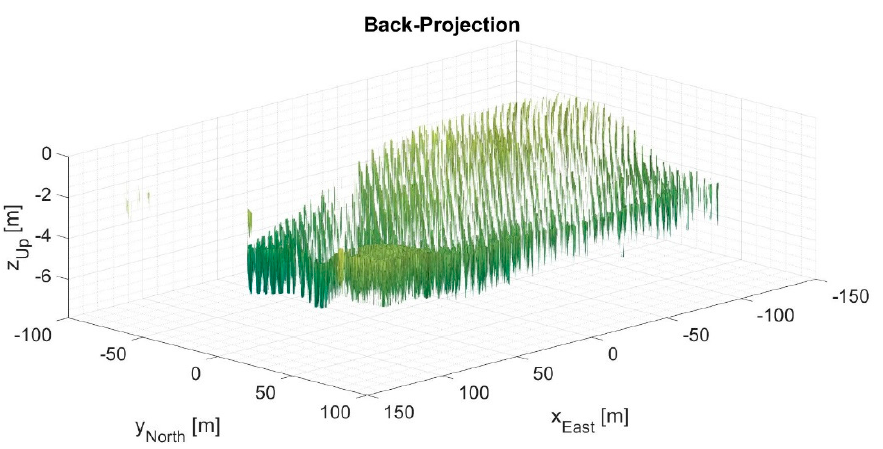
Figure 9. 3D output image processed by the back ‐ projection (BP) algorithm. Perspective view of isosurfaces at − 15 dB normalized magnitude.